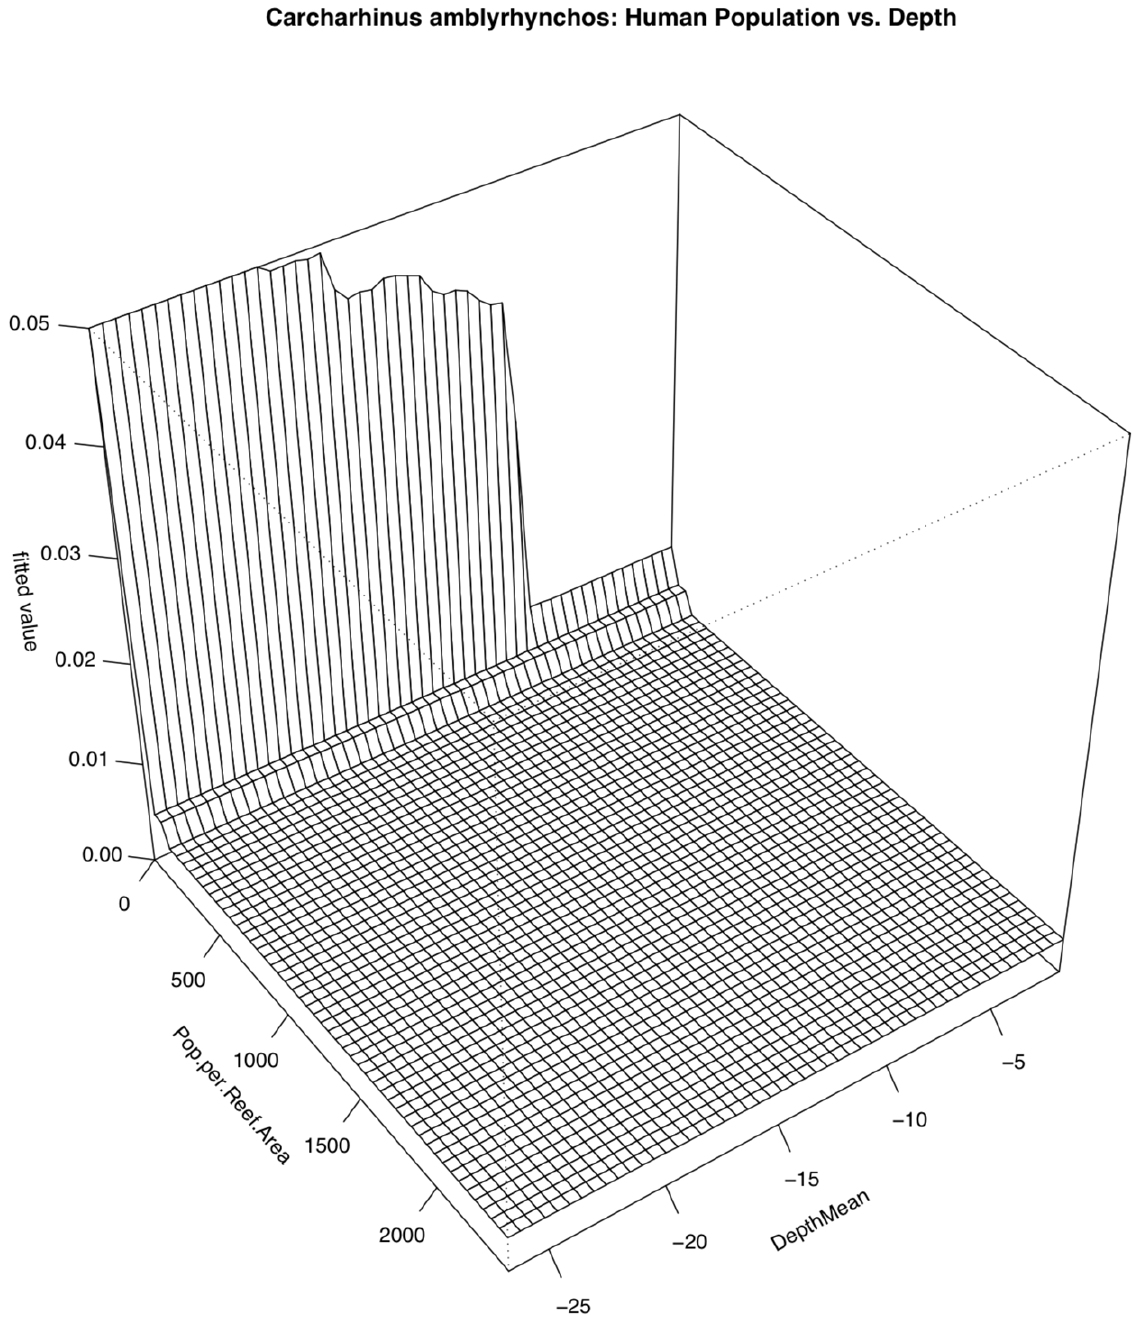
Figure 7. Pairwise interaction between human population density and depth with respect to occurrence of Carcharhinus amblyrhynchos . Depth is only influential in areas of low human population density and the effect of human population density is reduced in shallow waters.